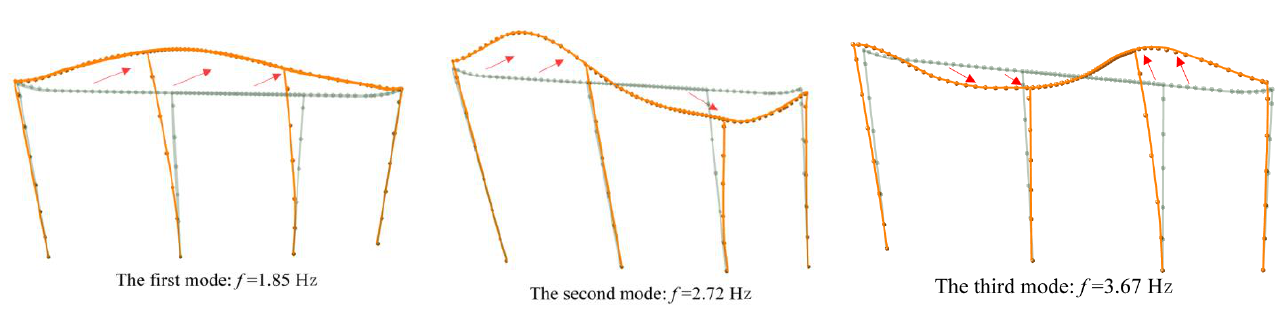
Figure 5. Mode and frequency. Figure 5. Mode and